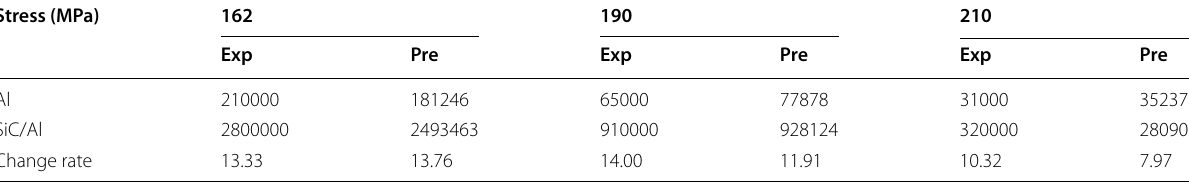
Table 5 Life increment of composite materials Stress